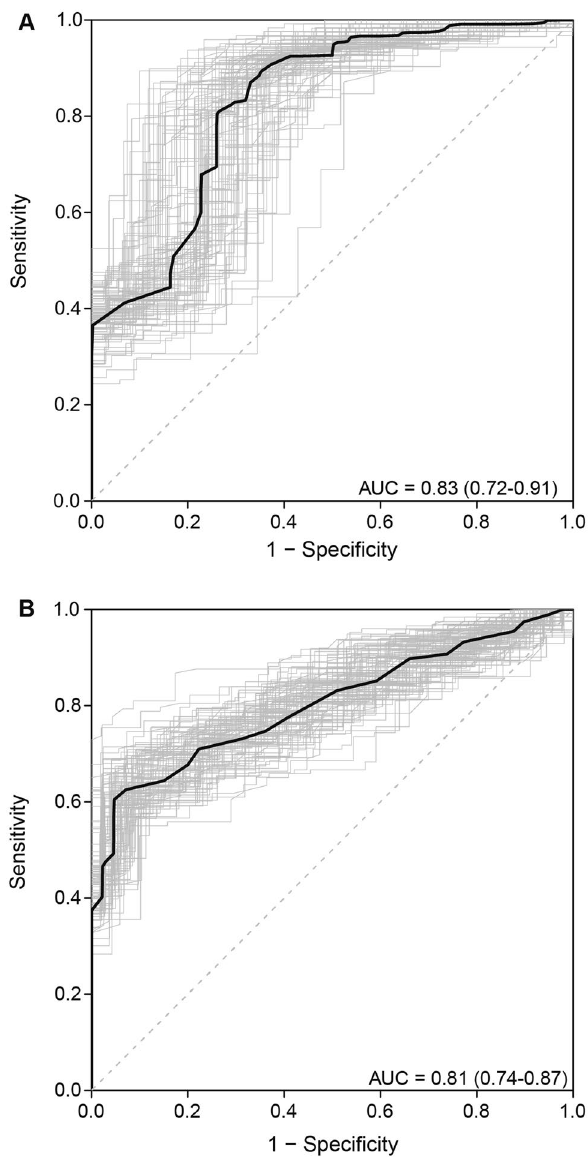
Figure 2. Receiver operating characteristic (ROC) curves for cfDNA concentration comparison between (A) healthy individuals and mCRPC, and (B) patients with localized disease and mCRPC. Area under the curve (AUC) and 95% CI were estimated with k-fold cross-validation and bootstrap